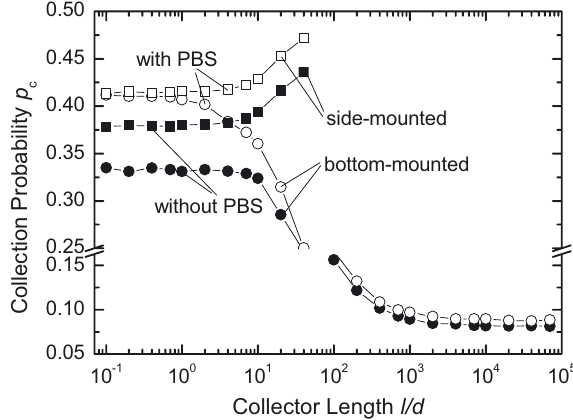
Fig. 10. Influence of a photonic band stop filter with an- gular selectivity. (a) Side-mounted system. Coverage fraction f = 0 . 9 achieves higher photon collections p c than f = 0 . 01 for all θ pbs . (b) Bottom-mounted system. For small scales the sys- tem shows a better performance than the side-mounted system because this system benefits from the randomization of photon direction during re-emission.